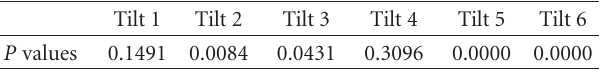
Table 3: P values for comparison of tilt